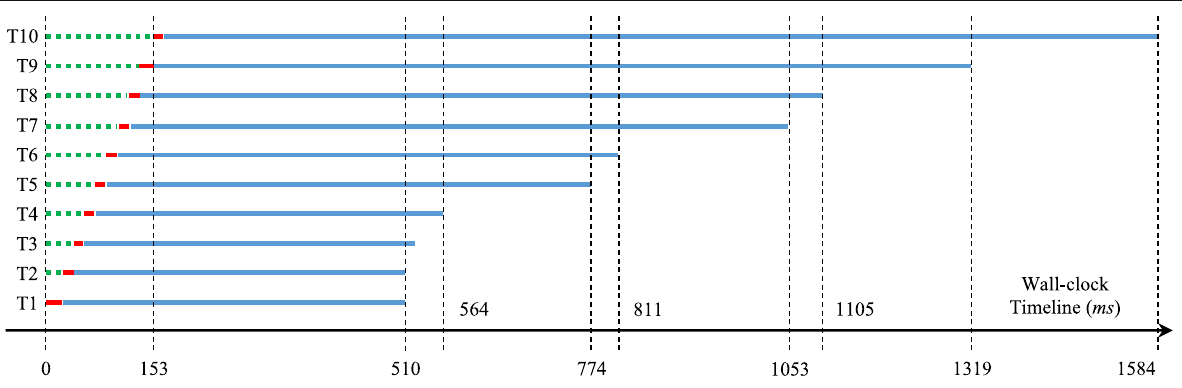
Fig. 6 Latency measurements for dealing with 10 consecutive prediagnosis tasks on our testbed. T1, T2..., and T10 indicates the 10 tasks respectively. The three parts of each line indicate the task queuing delay, the patient data processing latency, and the prediagnosis report uploading latency respectively (one millimeter represents 10 milliseconds)